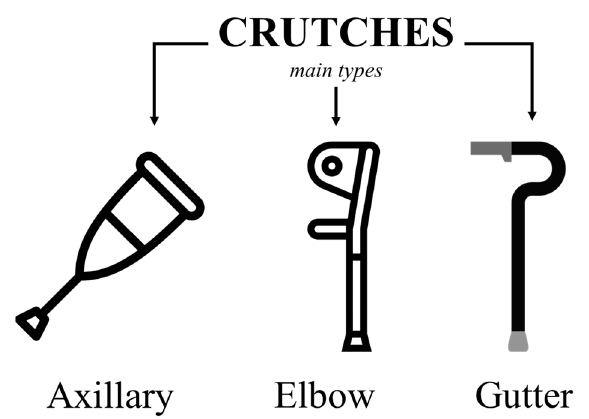
Figure 1. Main types of